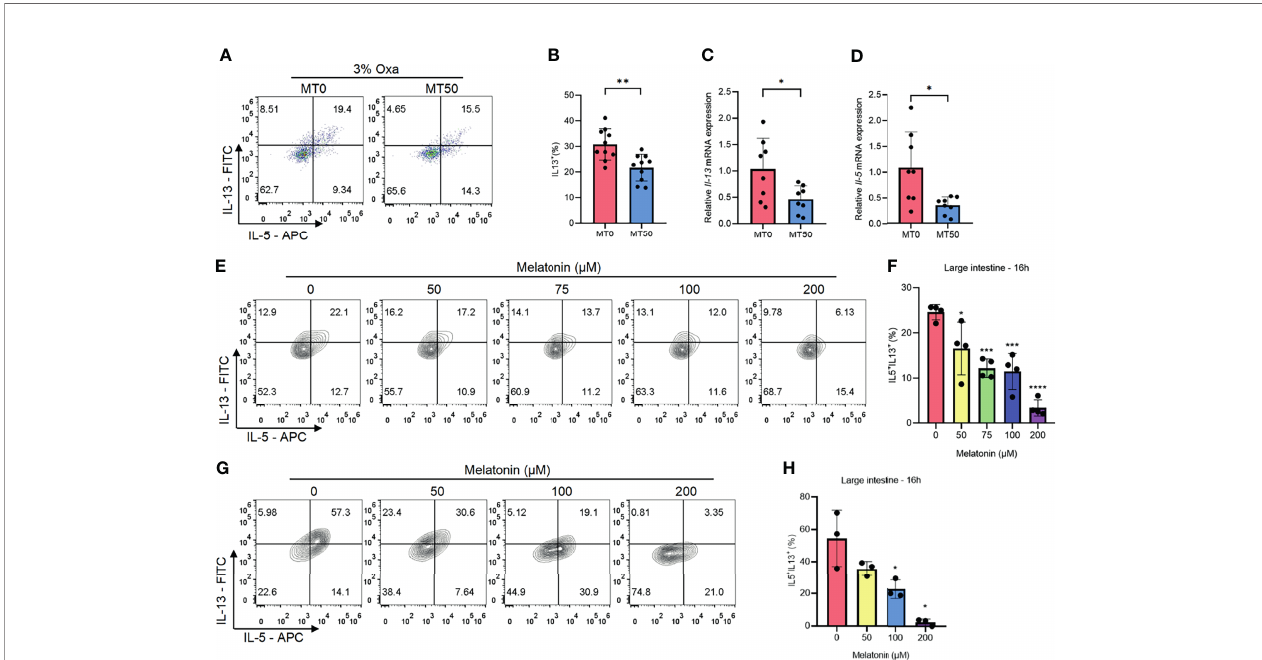
FIGURE 3 | Melatonin inhibits type 2 immunity in oxazolone (Oxa)-induced colitis. (A, B) Flow cytometry analysis of IL-5 and IL-13 in colonic CD45 + Lin − GATA3 + ILC2s and quanti fi cation of IL-13 in colonic ILC2s in melatonin-treated and melatonin-untreated mice at day 1 after 3% oxazolone enema. (C, D) qPCR of Il-5 and Il-13 mRNA of colonic tissue in melatonin-treated and melatonin-untreated mice at day 1 after 3% oxazolone enema (all values were normalized to the melatonin-untreated group). (E, F) Representative fl ow cytometry plots and quanti fi cation of large intestinal CD45 + Lin − GATA3 + ILC2 function treated with melatonin for 16 h in LPLs in vitro . (G, H) Representative fl ow cytometry plots and quanti fi cation of puri fi ed large intestinal CD45 + Lin − CD127 + KLRG1 + ILC2 function treated with melatonin for 16 h in vitro . Data are representative of at least two independent experiments. Data are shown as mean ± SD. * p < 0.05; ** p < 0.01; *** p < 0.001; **** p <